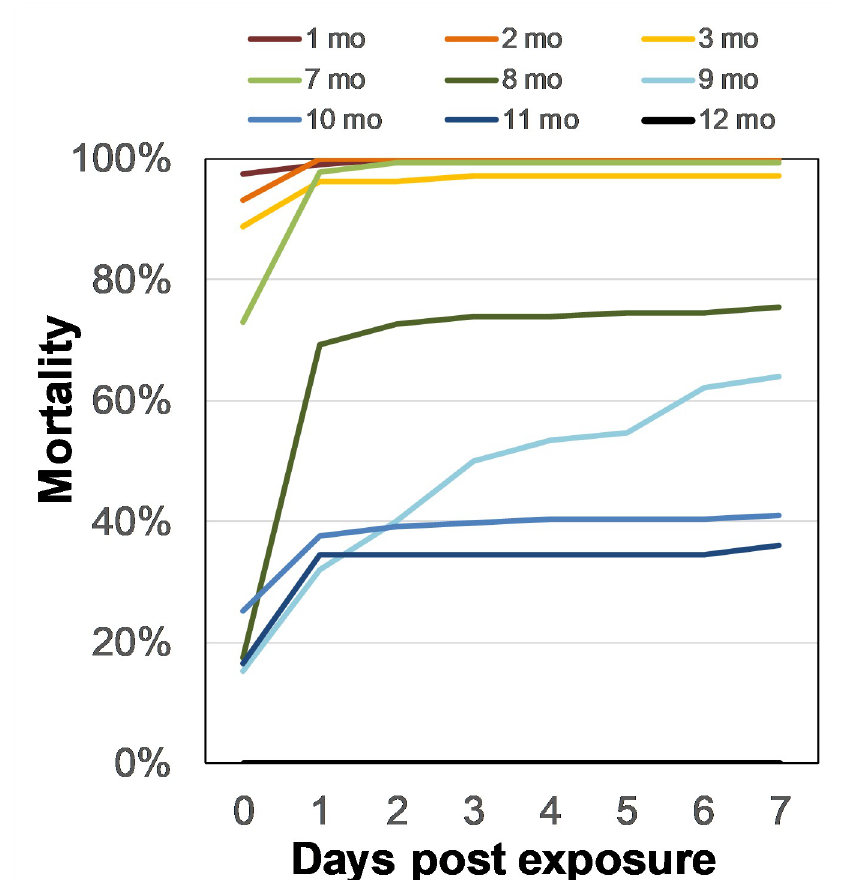
Fig 4. Cumulative delayed mortality at 1 to 12 months post-application (up to seven days after exposure to Sylando 240SC applied at 250 mg/m 2 via TIRS). The mortality at 24 h of collecting is represented as “0”. For 12 mo, mortality was 0 throughout the